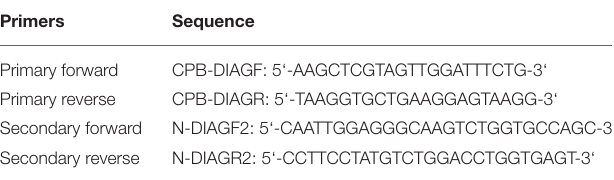
TABLE 2 | Primers used in